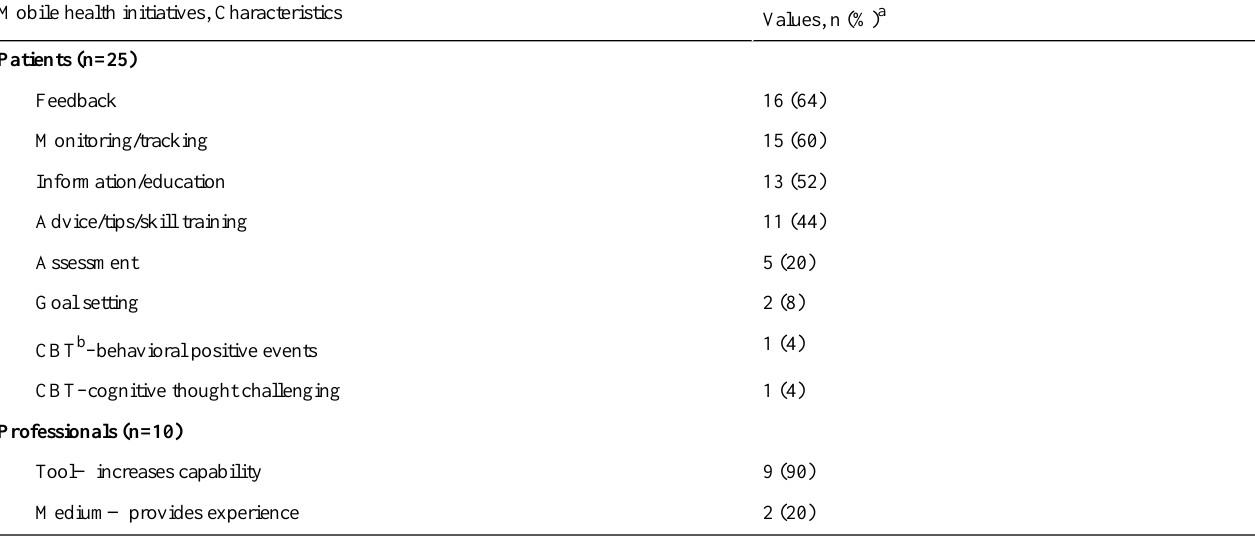
Table 2. Theoretical background and strategies (total number of mobile health